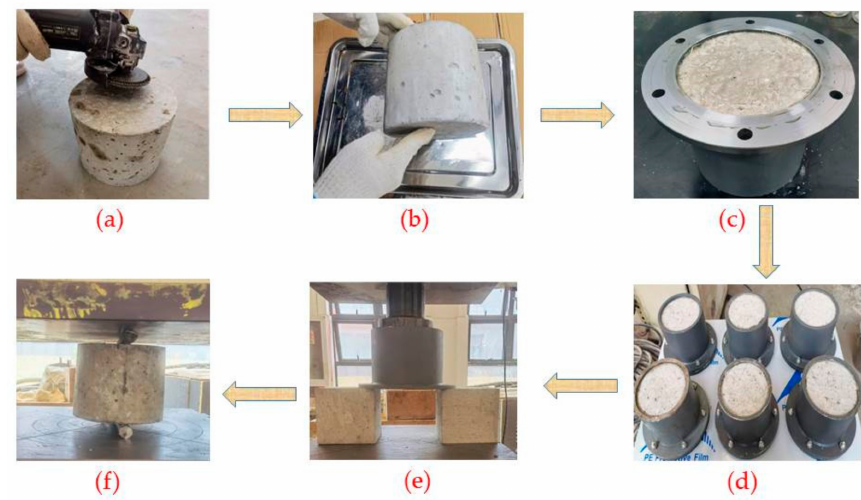
Figure 7. Process chart of impermeability test. ( a ) Sample grinding; ( b ) Sample sealing wax; ( c ) Sample installation; ( d ) impermeability test; ( e ) Take out the sample; ( f ) Split specimen.